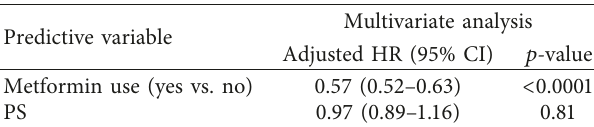
Table 4: Hazard ratios for AMD in PS-adjusted Cox